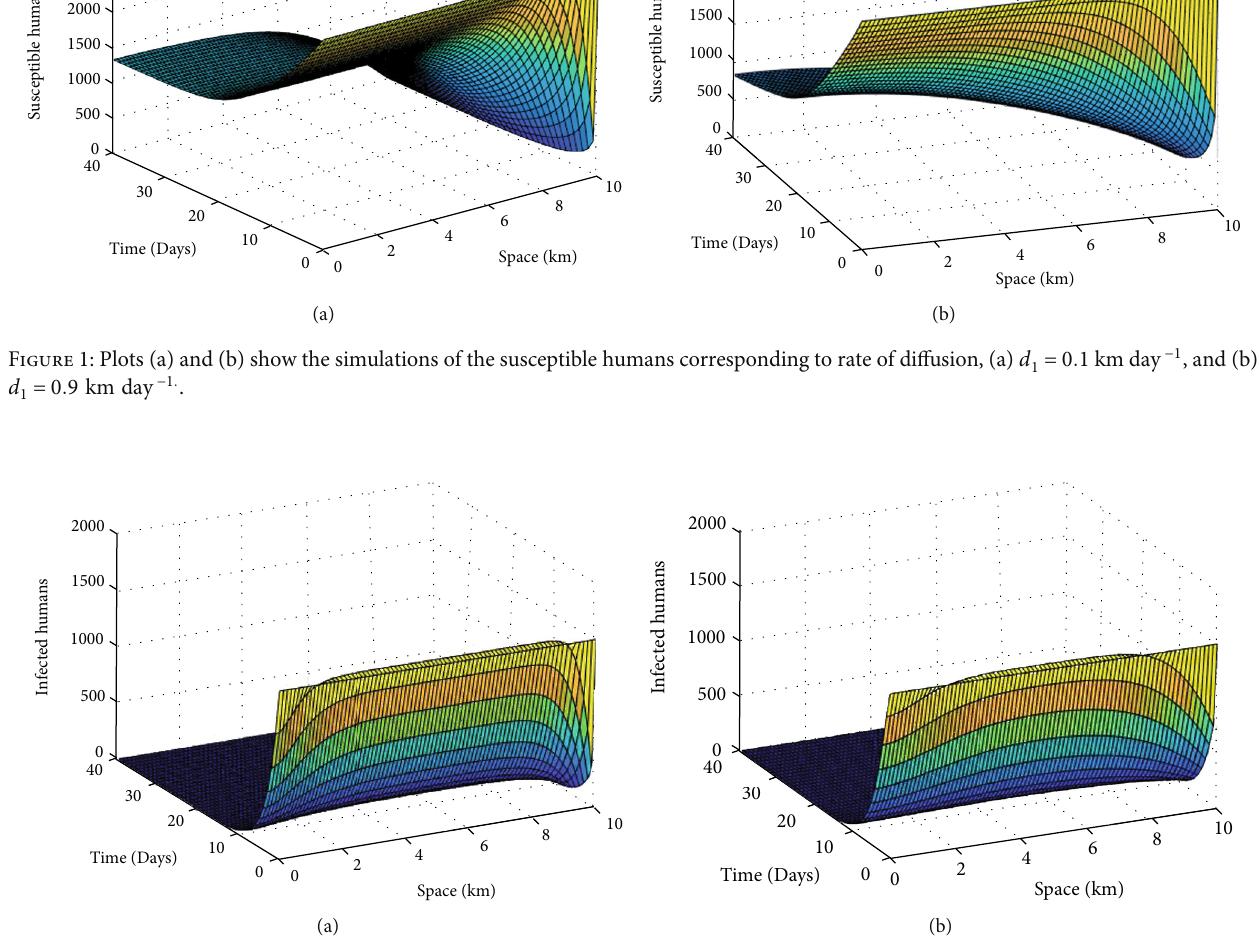
Figure 2: Plots (a) and (b) show the simulations of the Infected humans corresponding to the rate of di ff usion, (a) d (b) d 3 = 0 : 9 km day − 1